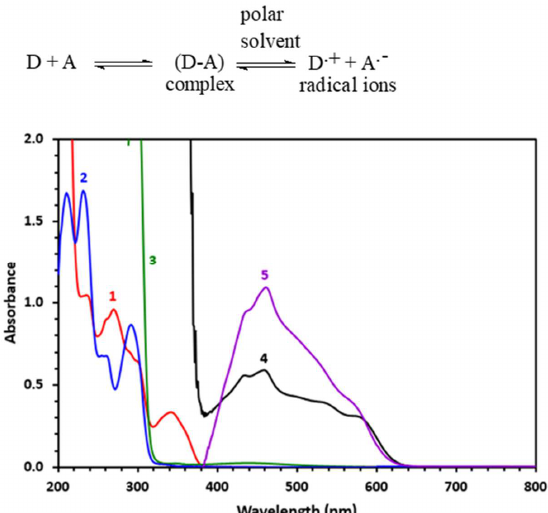
Figure 2. Absorption spectra of DUV (1), SEL (2), DDQ (3), reaction mixture of DUV with DDQ (4), and reaction mixture of SEL with DDQ (5). Concentrations of separate solutions of DUV, SEL, and DDQ were 20, 20, and 25 μg/mL, respectively. Concentrations of DUV and SEL in their reaction mixtures with DDQ (0.5%, w / v ) were 200 and 300 μg/mL, respectively. All solutions were in methanol.